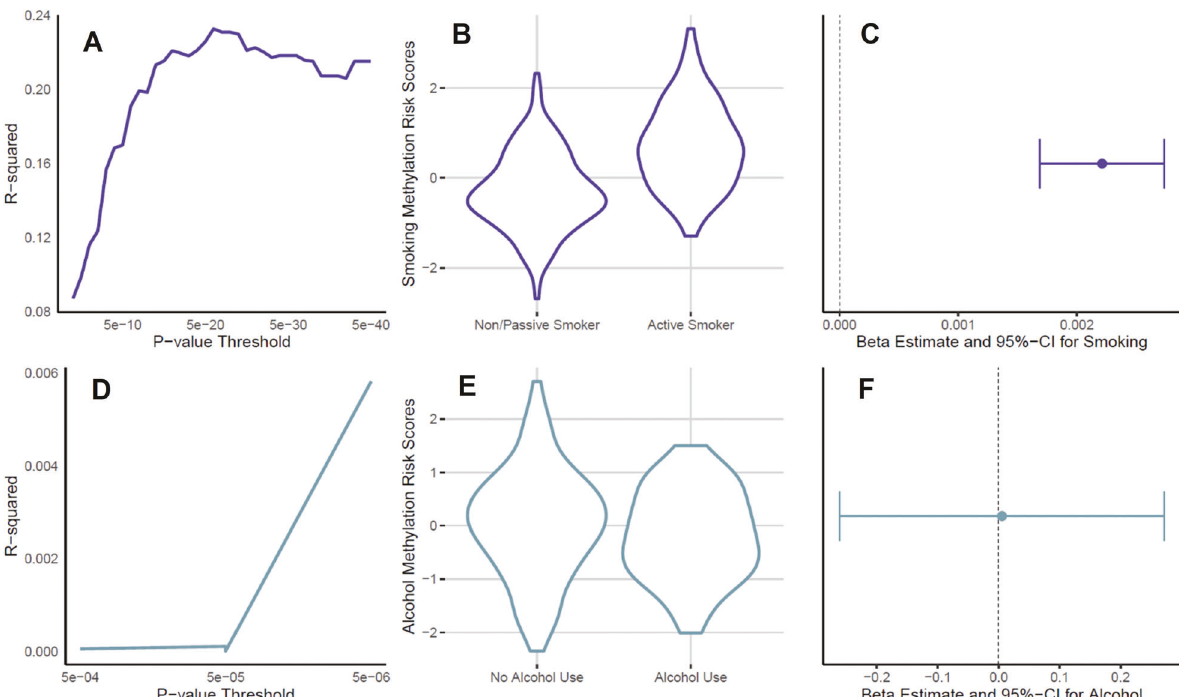
Fig. 2 Performance of the MRS for PTE ( N = 262) and PAE ( N = 262). A Correlation between PTE (continuous maternal urine cotinine levels) and MRS at several p value thresholds. B MRS ( p value threshold of 5e-21) for non-/passive smoking mothers and active smoking mothers. C Effect of PTE (continuous maternal urine cotinine levels) on most highly correlated MRS ( p value threshold of 5e-21). D Correlation between PAE and MRS at several p value thresholds. E MRS ( p value threshold of 5e-06) for non-alcohol consuming mothers and alcohol consuming mothers. F Effect of PAE on most highly correlated MRS ( p value threshold of